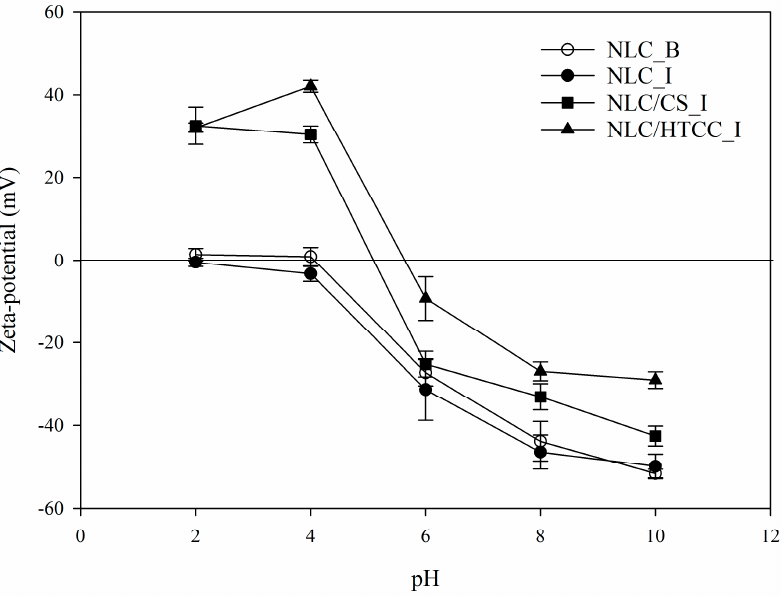
Figure 4. Zeta-potential profiles of different NLC formulations as a function of pH. NLC_B, blank NLC formulation; NLC_I, indomethacin loaded NLC formulation; NLC/CS_I: indomethacin loaded NLC formulation coated with chitosan; NLC/HTCC_I, indomethacin loaded NLC formulation coated with HTCC.